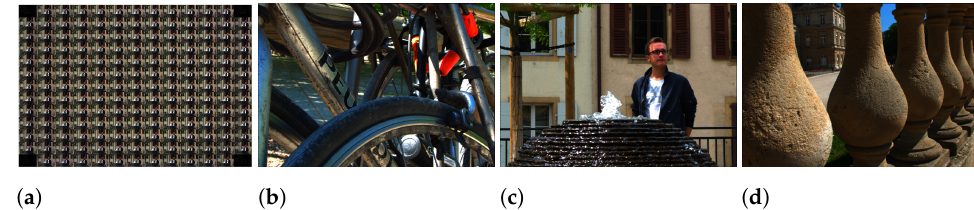
Figure 7. ( a ) The extracted 13 × 13 views of the Fountain-Vincent2 ; central view of ( b ) Bikes ; ( c ) Fountain-Vincent2 ; ( d ) Stone-Pillars Outside